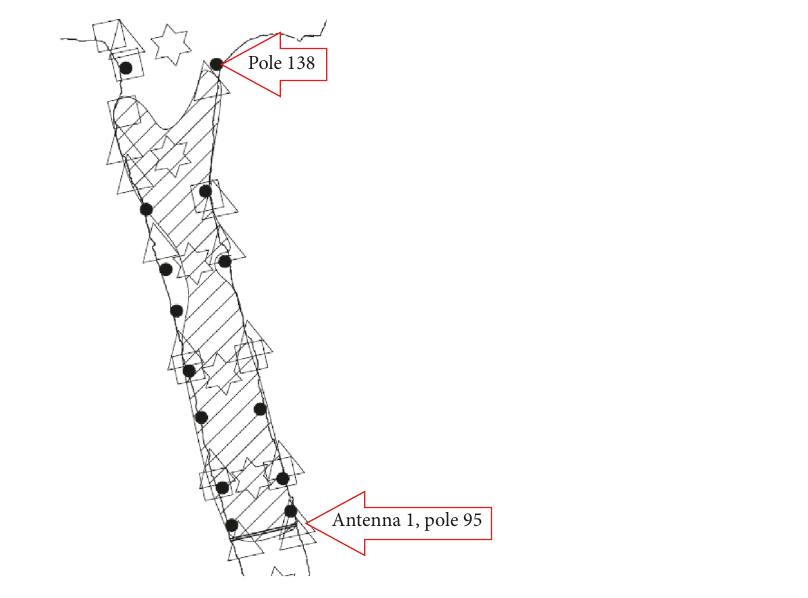
Figure 18: Antenna 1 rear reading area.